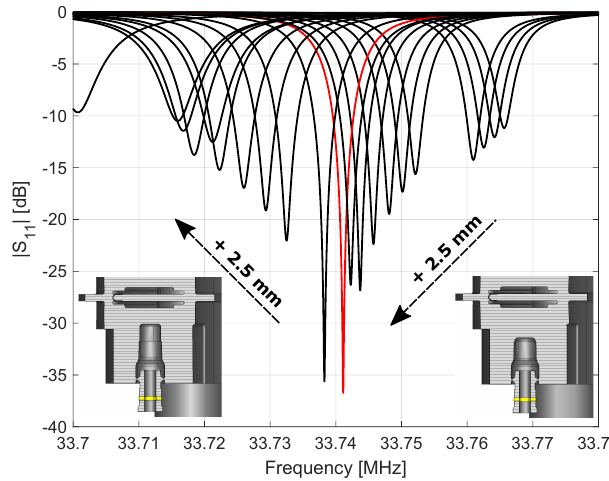
Figure 7. | S 11 | –parameter curves, for the cavity operating at f 0 (cid:39) 33.74 MHz, obtained by varying the distance of the coupler capacitor from the median plane. The red curve shows the best matching found when d = 123.5 mm. From right to left the movable coupler tip has been inserted into the cavity, with steps of 2.5 mm, starting at d = 146 mm and reaching d = 96 mm.